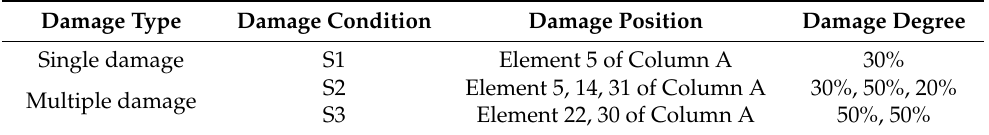
Table 2. Damage conditions of the headframe